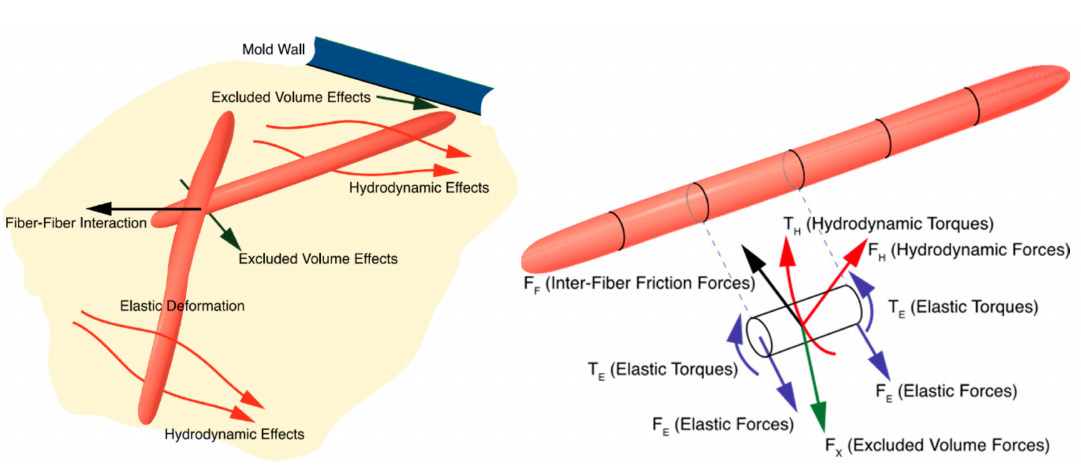
Figure 2. Depiction of forces and interactions calculated by direct fiber